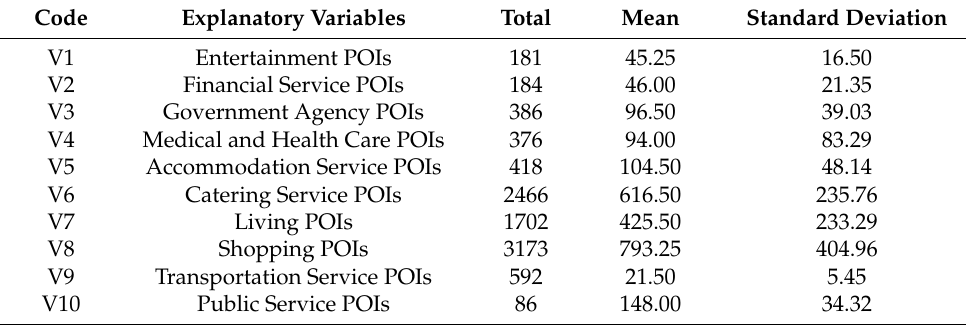
Table 4. Definition and descriptive statistics of explanatory